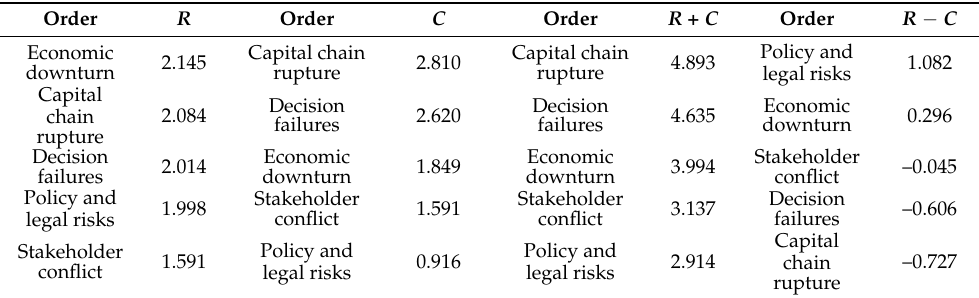
Table 10. Prioritization of alternatives in DEMATEL method.